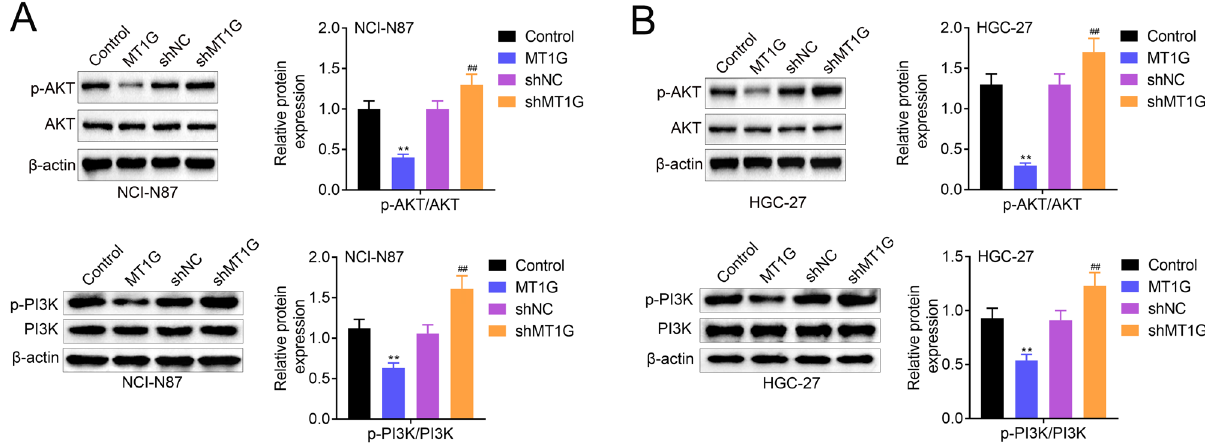
Figure 5 – MT1G deficiency induces PI3K/AKT signaling in gastric cancer cell. (A-B) Gastric cancer cells (NCI-N87 and HGC-27) were divided into four groups based on its different treatment with plasmids transfection, including MT1G overexpression plasmids and related control plasmids, MT1G knockdown plasmids-sh MT1G and matched negative control plasmids-shNC. The expression of AKT, p-AKT, PI3K, p-PI3K in MT1G overexpression or knockdown NCI-N87 (A) and HGC-27 (B) cells was measured by western blotting. Error bars represent data from three independent experiments (mean±SD). ** P<0.01.